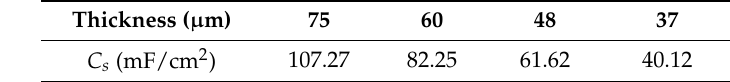
Table 2. Specific capacitances of different buckypaper thicknesses at 20 mV/s scan rate.